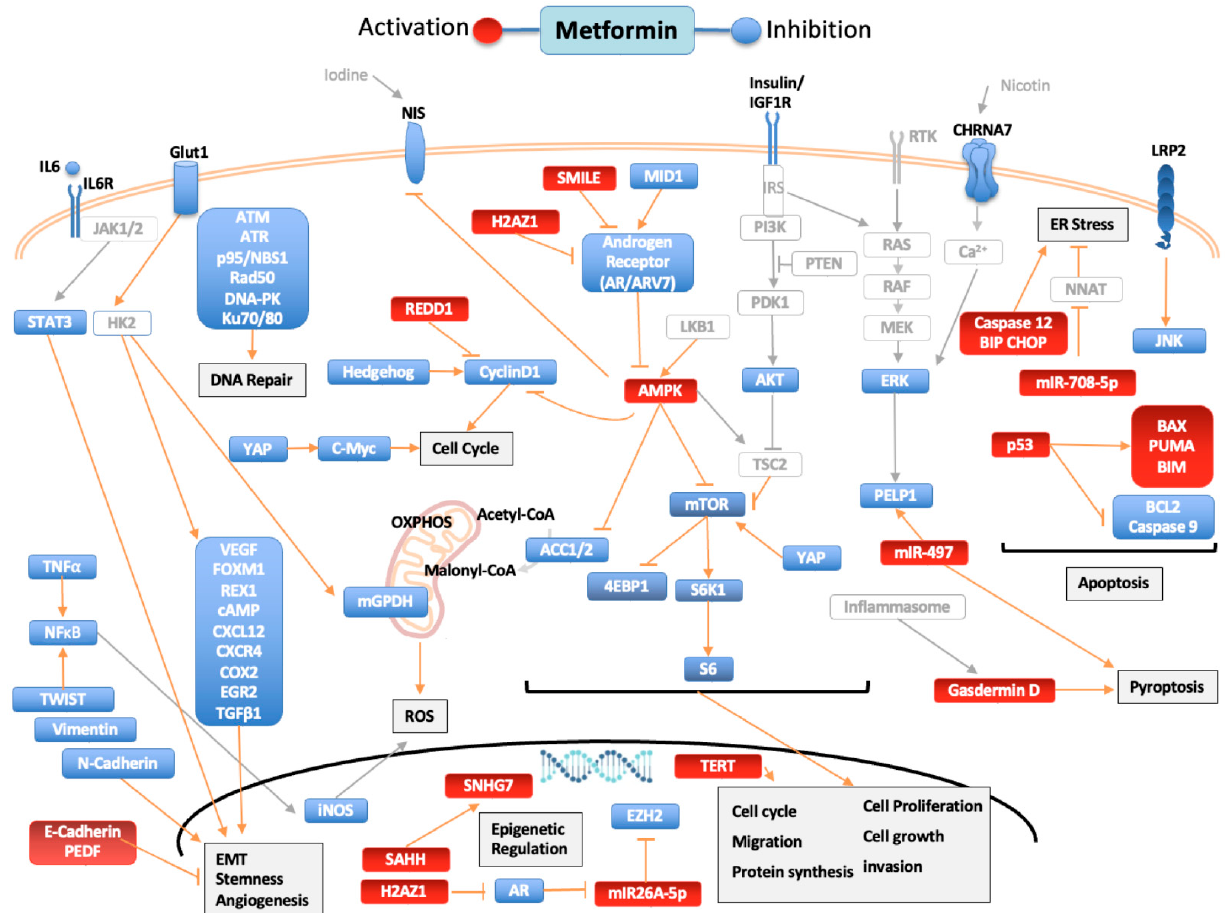
Figure 1. Pathways regulated by metformin in thyroid, prostate, and head and neck cancers. Blue targets show inhibited or downregulated, and red targets show activated or upregulated by metformin. Signaling molecules and arrows in gray have no direct relationship described with metformin. Acetyl-CoA carboxylase (ACC), AKT Serine/Threonine Kinase (AKT), AMPK (adenosine monophosphate-activated protein kinase), androgen receptor (AR), Androgen receptor variant 7(ARV7), Ataxia Telangiectasia Mutated (ATM), Ataxia Telangiectasia And Rad3-Related Protein (ATR), Na+/I- symporter (NIS), BCL2 Associated X, Apoptosis Regulator (BAX), Bcl-2 Interacting Mediator Of Cell Death (BIM), B-Cell CLL/Lymphoma 2 (BCL2), Binding-Immunoglobulin Protein (BIP), Cholinergic Receptor Nicotinic Alpha 7 Subunit (CHRNA7), C/EBP Homologous Protein (CHOP), cyclic AMP (cAMP), C-X-C motif chemokine receptor 4 (CXCR4), C-X-C Motif Chemokine Ligand 12 (CXCL12), Cyclooxygenase 2 (COX2), DNA-dependent protein kinase (DNA-PK), Endoplasmic reticulum (ER), Early Growth Response 2 (EGR2), Epithelial–mesenchymal transition (EMT), Eukaryotic Translation Initiation Factor 4E Binding Protein 1